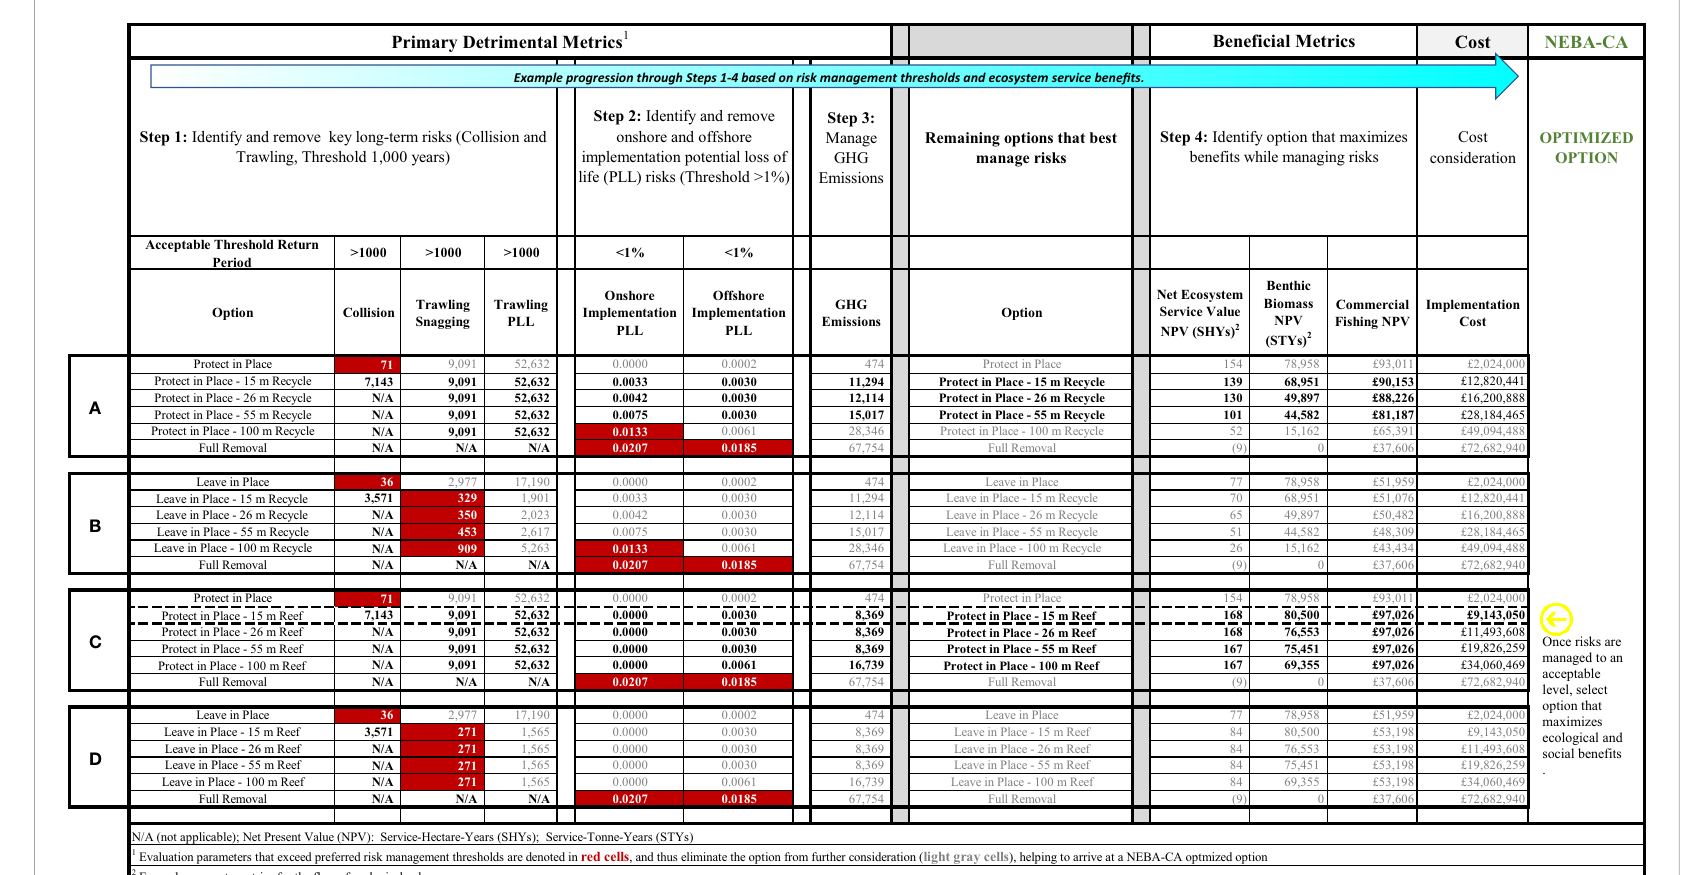
FIGURE 7 NEBA-CA Risk Management